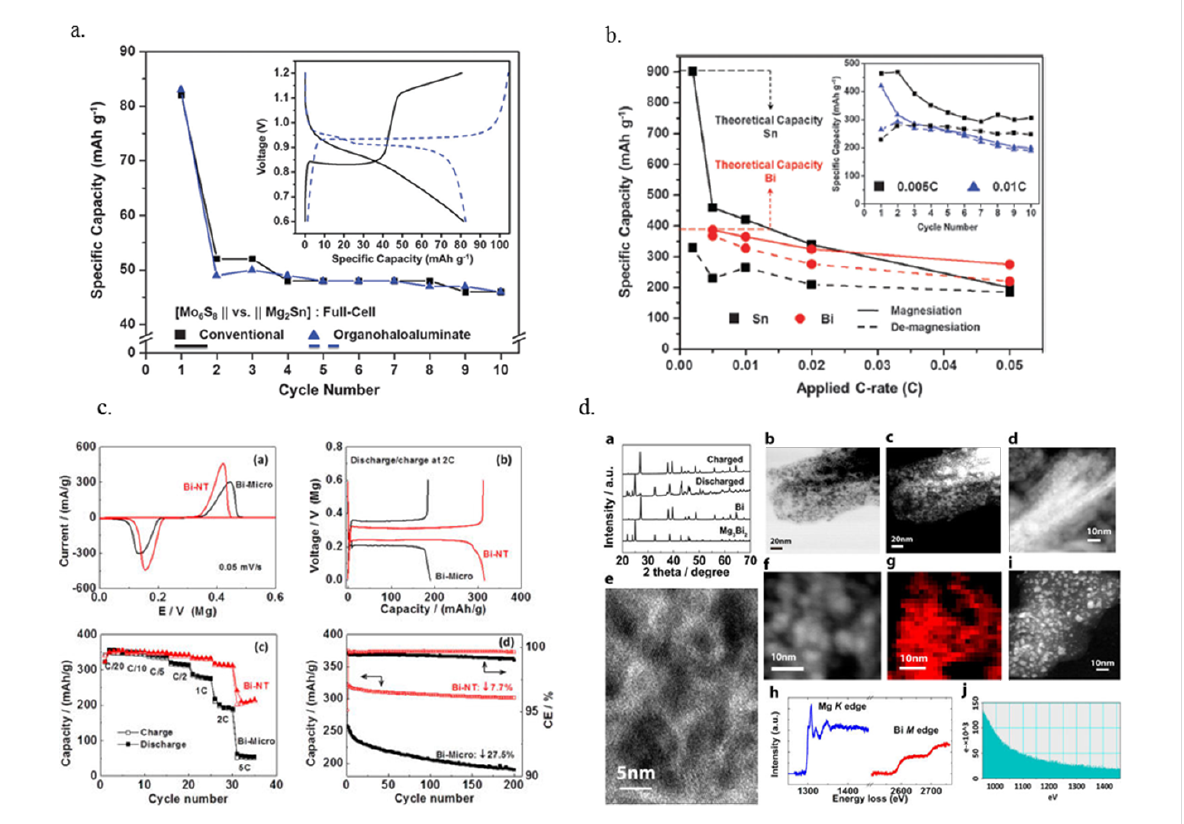
Figure 3: For Sn anode: a) The first 10 cycles for a Mg 2 Sn (anode), Mo 6 S 8 (cathode) in conventional and organohalo-aluminate electrolytes, inset – 1st cycle voltage profiles; b) insertion/extraction capacities for Sn/Mg and Bi/Mg (half-cells) in an organohaloaluminate electrolyte at various C-rates. Inset – 10 cycles of a Sn/Mg half-cell at 0.005 C and 0.01 C. Figures 3a and 3b are reproduced with permission from [15]. Copyright 2013 The Royal Society of Chemistry. For Bi nanotubes anode: c) Performance comparison between Bi micro and nanotube (half cell); d) Morphology and structure evolution of Bi nanotubes during Mg insertion /extraction. Figure 3c and 3d are reprinted with permission from [16]. Copyright 2013 American Chem- ical